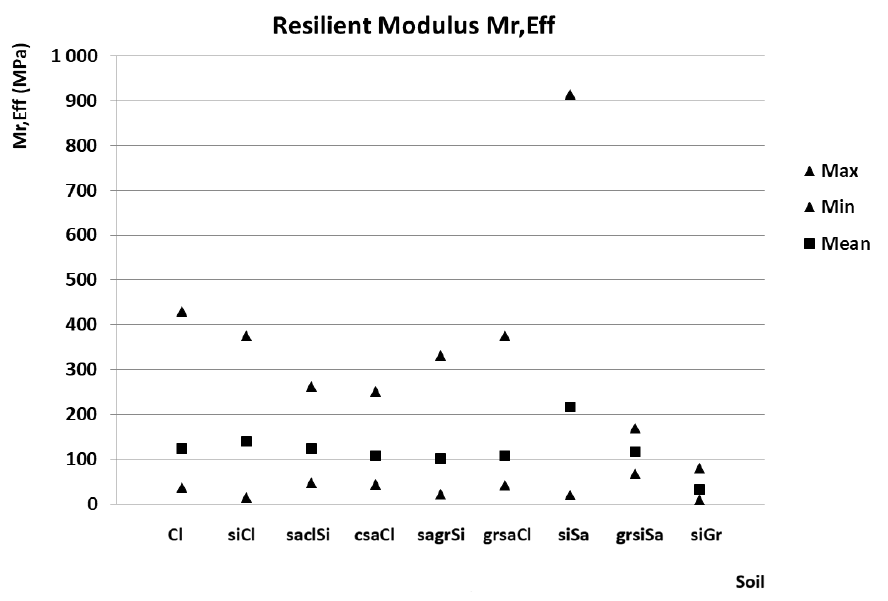
Figure 1. Resilient modulus M r,eff for individual soil classes.